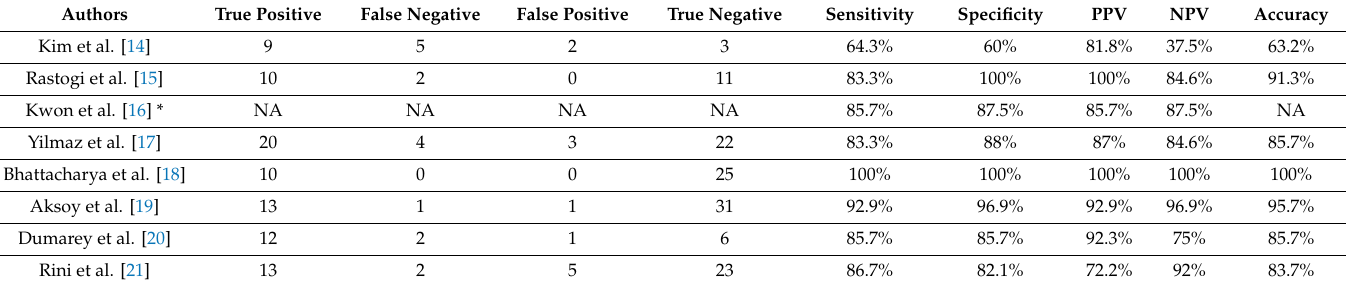
Table 3. Diagnostic accuracy data of 18 F-FDG WBC PET or PET / CT in the included studies on a per patient-based